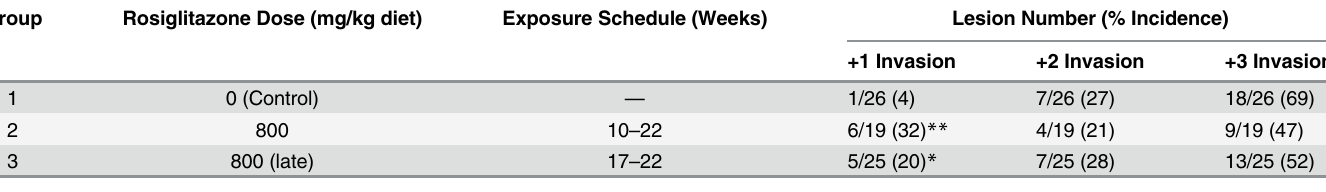
Table 3. Influence of Rosiglitazone on Oral Cancer Invasion Scores in NQO-Treated F344 Rats. Group Rosiglitazone Dose (mg/kg